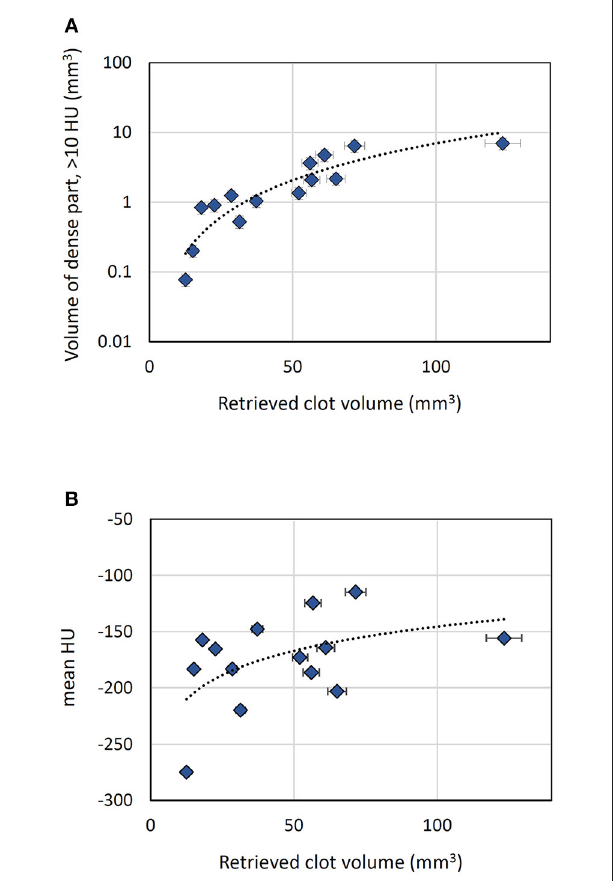
FIGURE 4 | Volumetric analysis of the retrieved clots (data points refer to formalin-fixed clots). (A) Correlation between the volume of dense part of the clot and the overall clot volume. (B) Variation of clot average density (mean HU) with the clot